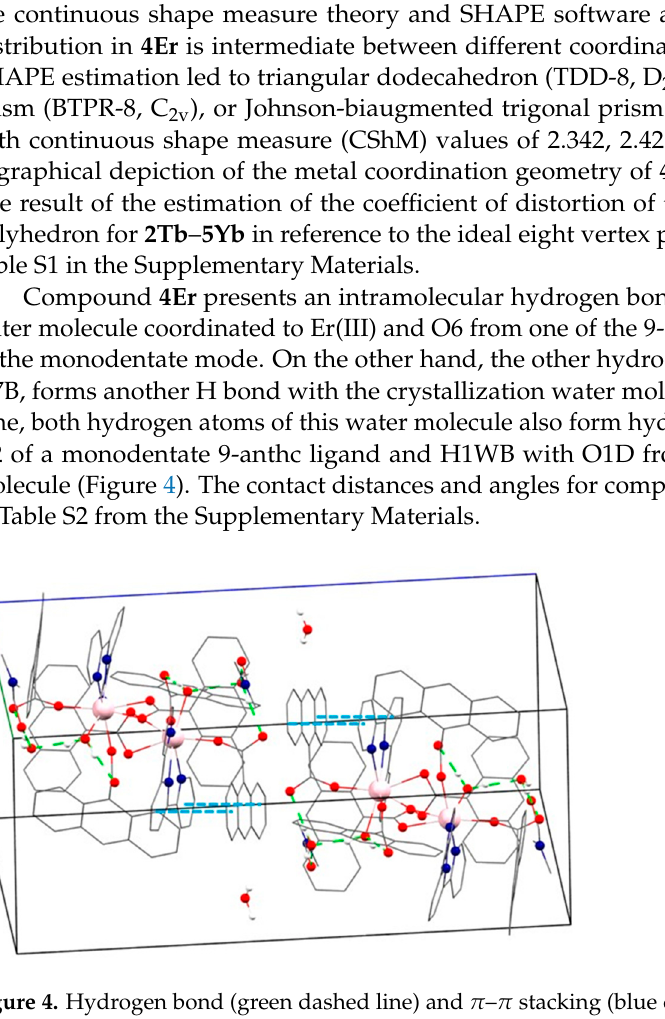
Figure 3. ( a ) Partially labeled structure of 4Er . H atoms are omitted for clarity. Color code: gray = C, blue = N, red = O, and light pink = Er. ( b ) Coordination polyhedron of the Er(III) ion in 4Er . The structure of compound 4Er consists of [Er(9-anthc) 3 (TPY)(H 2 O)] molecules in which each Er(III) ion is octa-coordinated. The Er(III) ion has an ErN 3 O 5 octa-coordination